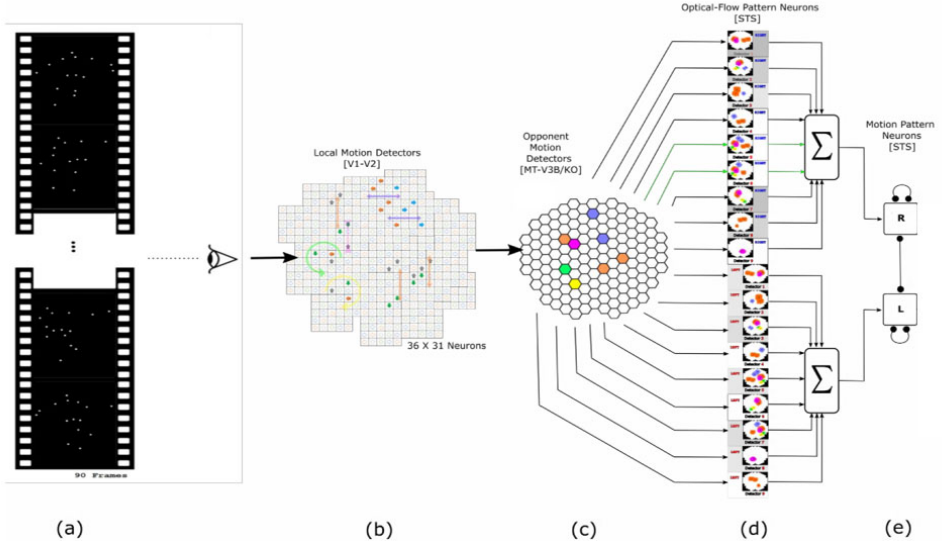
Figure 1. Schematic of the model in one hypothetical point in time, from left to right: ( a ) the reel of biological motion stimulus, ( b ) local motion detectors as an ensemble of 1116 neurons positioned in a 36 by 31 arrangement, that fire due to motions they experience during two consecutive frames, represented by the cells with color-filled arrows (blue: right, orange: left, grey: up, and green: down). The larger, two-headed, colorful arrows are drawn to display the types of opponent motions that would be sensed at the next level (cyan: horizontal expansion, orange: vertical expansion, and magenta: vertical contraction). ( c ) Opponent motion detectors as an ensemble of 100 neurons to detect horizontal expansion, horizontal contraction, vertical expansion, and vertical contraction. The activated detectors are marked with color-filled hexagons with their corresponding color (cyan: horizontal expansion, orange: vertical expansion, and magenta: vertical contraction). ( d ) Optical-flow pattern detectors as an arrangement of 18 neurons following one-dimensional mean-field dynamics, each neuron incorporates a statistical template (displayed as a colorful map) that represents a specific part of the manifold of the kicking sequences (for example neuron number two contains a template for the seconds 11 to 20 of the kick-to-right sequence, while neuron number 10 would have a larger instantaneous input for the seconds 1 to 10 of the kick to the left stimulus). Green arrows highlight the contribution of two cells to the evidence integration at that hypothetical point due to the similarity of the evidence signal and their template. ( e ) Thresholding stage, comprising two decision neurons for the right and left decisions (marked by capital letters R and L on the square cells with soft edges) follow our mutual inhibition dynamics receiving their corresponding inputs from the integration stage. The straight and curve lines with rounded heads highlight the inhibitory interaction between the neurons and the auto-inhibition, respectively. No activity could be seen by either of the neurons since at that hypothetical point in time, neither had made a decision